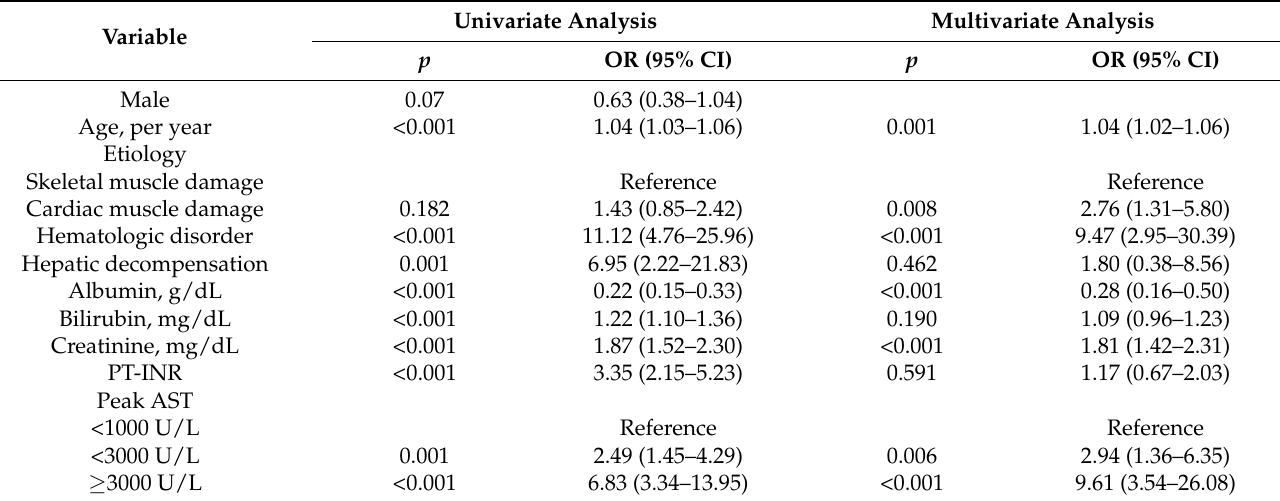
Figure 3. Kaplan–Meier curve for survival according to ( a ) peak AST level and ( b ) etiologic group. The skeletal muscle group was used as a reference for the etiologic groups while peak AST levels < 1000 IU/L was used as a reference for peak AST levels in the logistic regression analyses. In the univariate analysis, age (OR = 1.04 per year, 95% CI = 1.03–1.06), hepatic decompensation (OR = 6.95, 95% CI = 2.22–21.83), albumin level (OR = 0.22, 95% CI = 0.15–0.33), bilirubin level (OR = 1.22, 95% CI = 1.10–1.36), creatinine level (OR = 1.87, 95% CI = 1.52–2.30), PT-INR (OR = 3.35, 95% CI = 2.15–5.23), hematologic disorder (OR = 11.12, 95% CI = 4.76–25.96), peak AST < 3000 U/L (OR = 2.49, 95% CI = 1.45–4.29), and peak AST ≥ 3000 U/L (OR = 6.83, 95% CI = 3.34–13.95) were associated with 30-day mortality. In the multivariate analysis, age (adjusted OR = 1.04 per year, 95% CI = 1.02–1.06), albumin level (adjusted OR = 0.28, 95% CI = 0.16–0.50), creatinine level (adjusted OR = 1.81, 95% CI = 1.42–2.31), cardiac muscle damage (adjusted OR = 2.76, 95% CI = 1.31–5.80), hematologic disorder (adjusted OR = 9.47, 95% CI = 2.95–30.39), peak AST < 3000 U/L (adjusted OR = 2.94, 95% CI = 1.36–6.35), and peak AST ≥ 3000 U/L (adjusted OR = 9.61, 95% CI = 3.54–26.08) were independently associated with 30-day mortality (Table 3). Table 3. Risk factors of 30-day mortality in univariate and multivariate logistic regression analyses ( n =